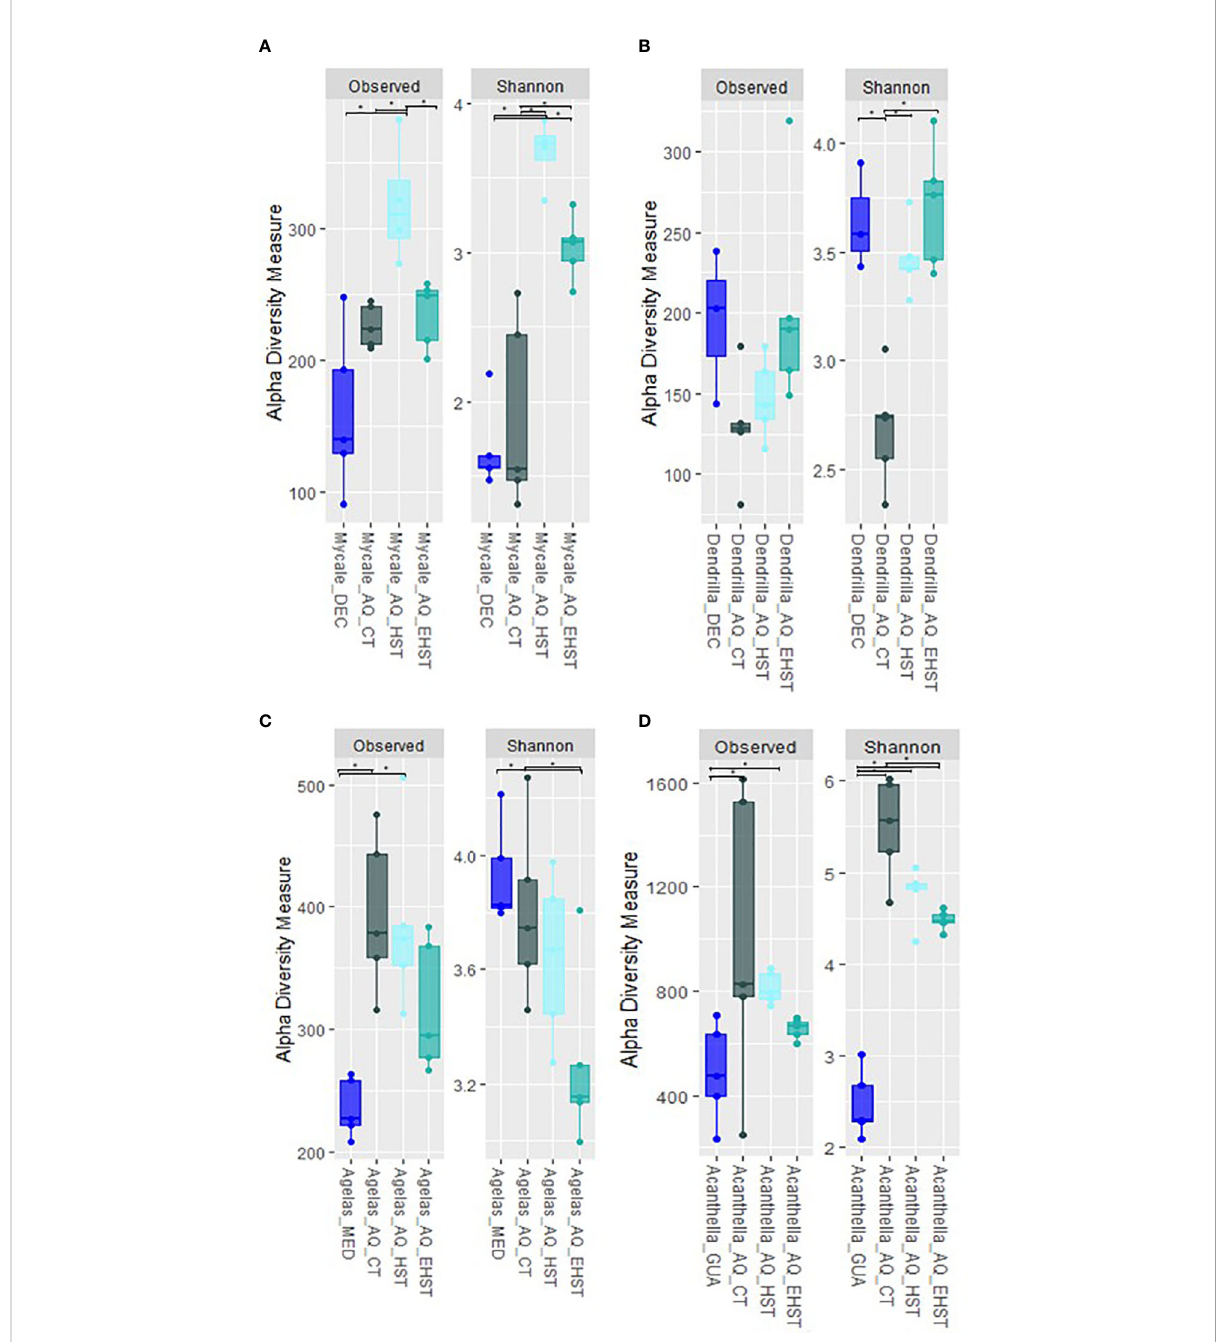
FIGURE 5 Alpha-diversity measurements of the bacterial communities of sponge specimens in aquaria experiments at the different experimental temperatures (CT, control temperature, HST, heat stress temperature, EHST, extreme heat stress temperature) compared to the natural habitat specimens: (A) M. acerata from Deception Island; (B) D . antarctica from Deception Island; (C) A . oroides from Cadaque ́ s and Roses; (D) A. cavernosa from Guam. AQ, aquarium experiments. * p-value